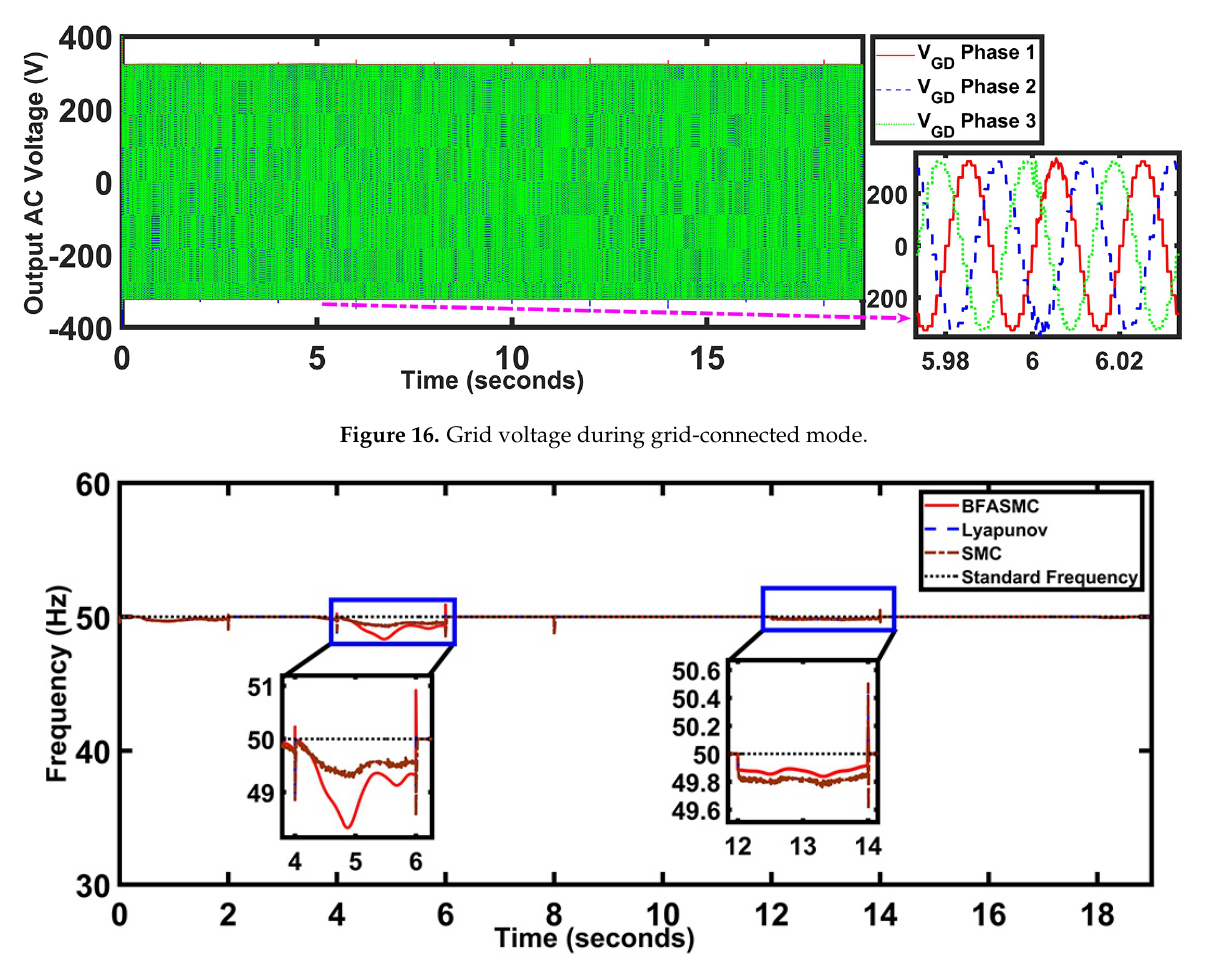
Figure 17. Frequency comparison.